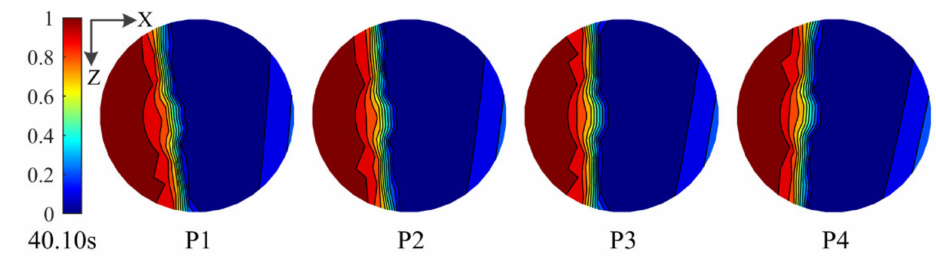
Figure 20. The compression damage of concrete in the core area at 40.10